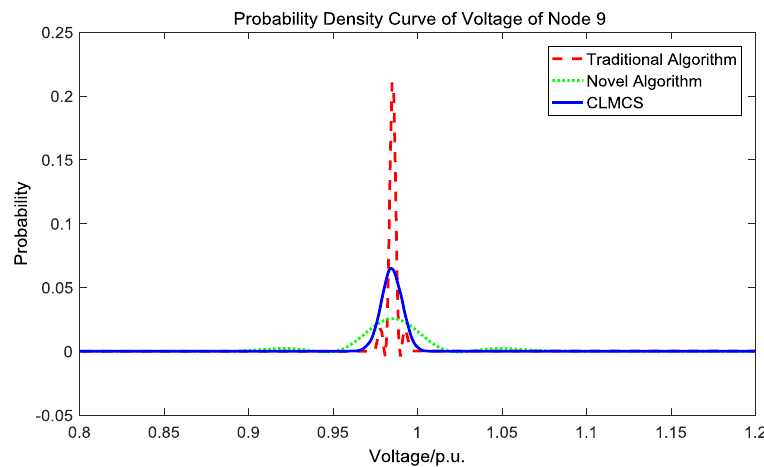
Figure 4. Probability density curves of voltage for node 9. p.u.: per unit.